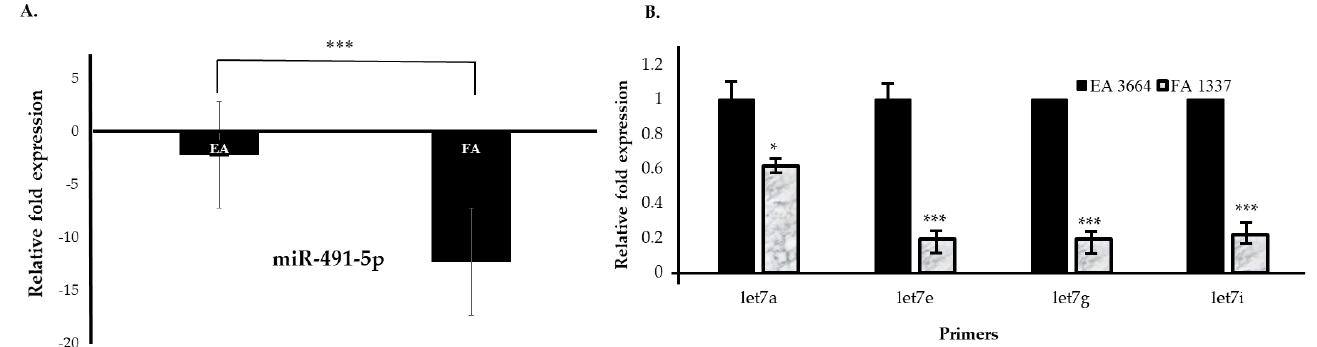
Figure 7. Downregulated miRNA signature validation by RT-qPCR. The RT-qPCR assays for miRNAs were performed with specific primers for miR-491-5p and let-7 genes. Relative downregulation ( ∆∆ Ct) values of miR-491-5p and let-7 gene family are compared in European Americans ( n = 43) versus Filipino Americans ( n = 46). Significantly lower expression is noted in Filipino Americans compared to European Americans. ( A ) miR-491-5p (*** p < 0.001) and ( B ) let-7 subfamilies: let-7a (* p < 0.05), let-7e (*** p < 0.001), let-7g (*** p < 0.001), let-7i (*** p <